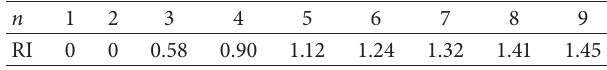
Table 4: Consistency random index